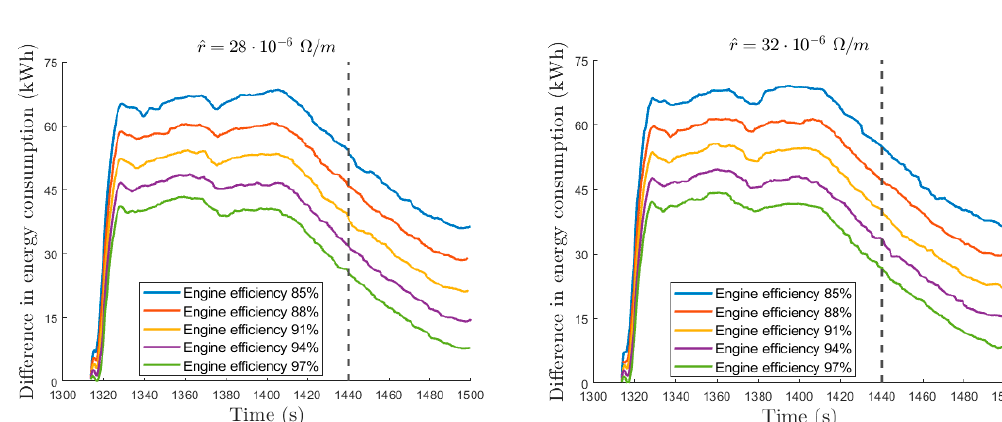
Figure 7. Difference in energy consumption (in kWh) between the considered driving strategies at the electrical substations for the Calatayud–Zaragoza section for different values of the catenary linear resistance 𝑟̂ . Three different scenarios can be distinguished. Close to the flat-out running time, there is a large increase in the difference in energy consumption between the eco-driving and the standard driving strategies; this is due to the action of the final coasting phase in the former driving strategy. Next, there is a scenario in which the difference is approximately constant. For the slowest speed profiles, the difference in energy consumption is significantly lower, as can be seen in Figure 5, and the difference in energy consumption between the considered driving strategies becomes smaller as the running time increases, as the coasting phase will be shorter and therefore its impact will be less